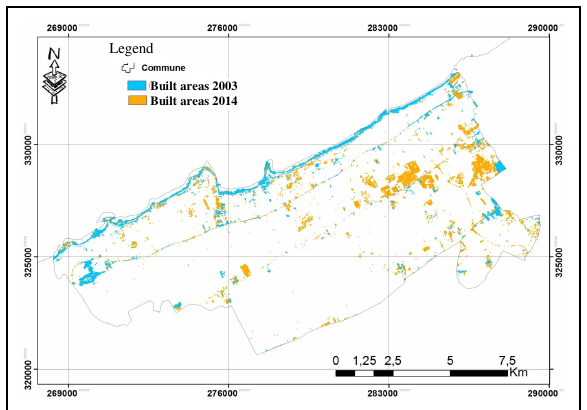
Figure 2: Comparison of the built-up area at Dar Bouazza between 2003 and 2014